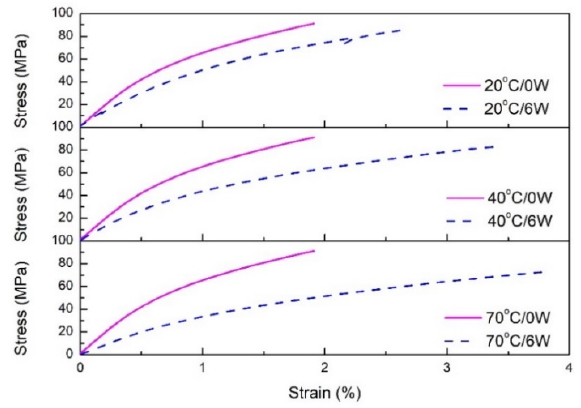
Figure 12. E ff ect of water absorption on the stress-strain curves of nano-clay grafted FFRPs at di ff erent Figure 12. Effect of water absorption on the stress ‐ strain curves of nano ‐ clay grafted FFRPs at different temperatures under 80% temperatures under 80% RH.